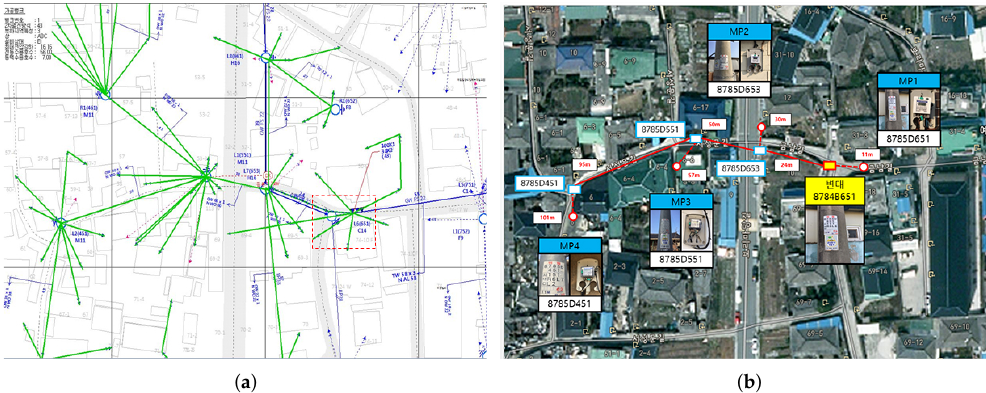
Figure 19. Example of the NDIS map (Site 1-2, Overhead Residential Area). ( a ) NDIS map with a utility pole and distribution lines. ( b ) Aerial photography with a utility pole and